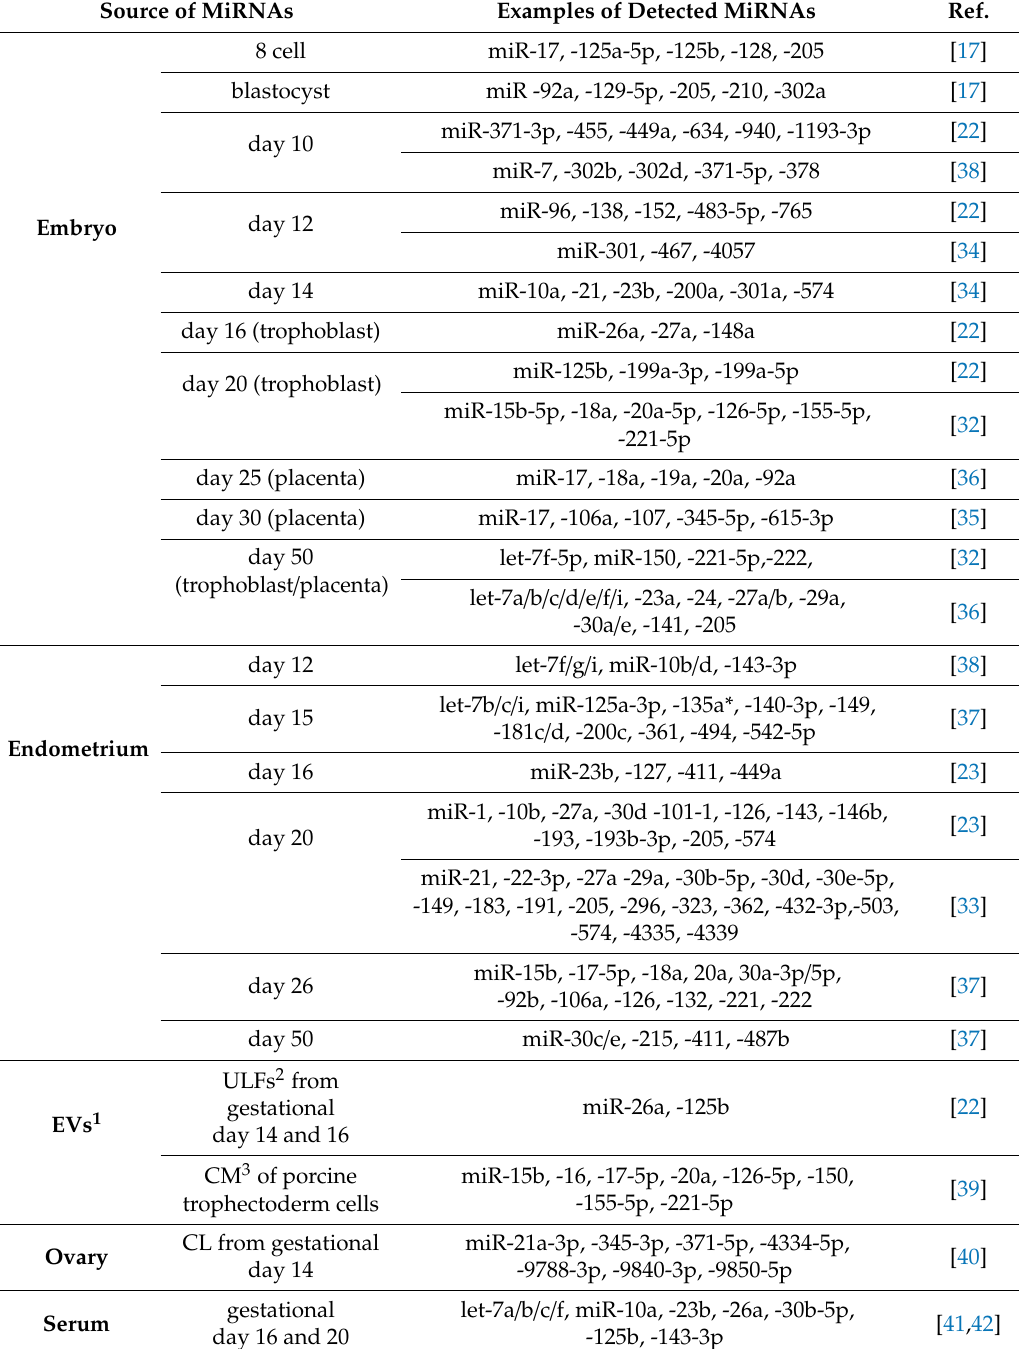
Table 1. Examples of microRNAs (miRNAs) detected in pregnant pigs. Source of MiRNAs Examples of Detected MiRNAs